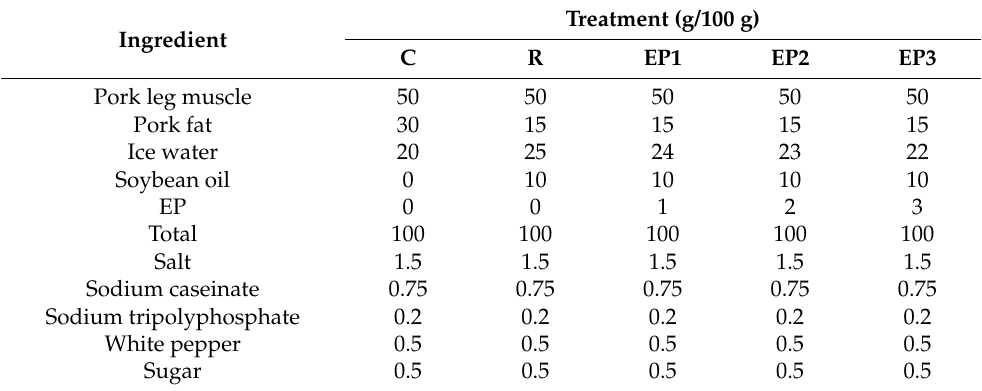
Table 1. Formulation of pork